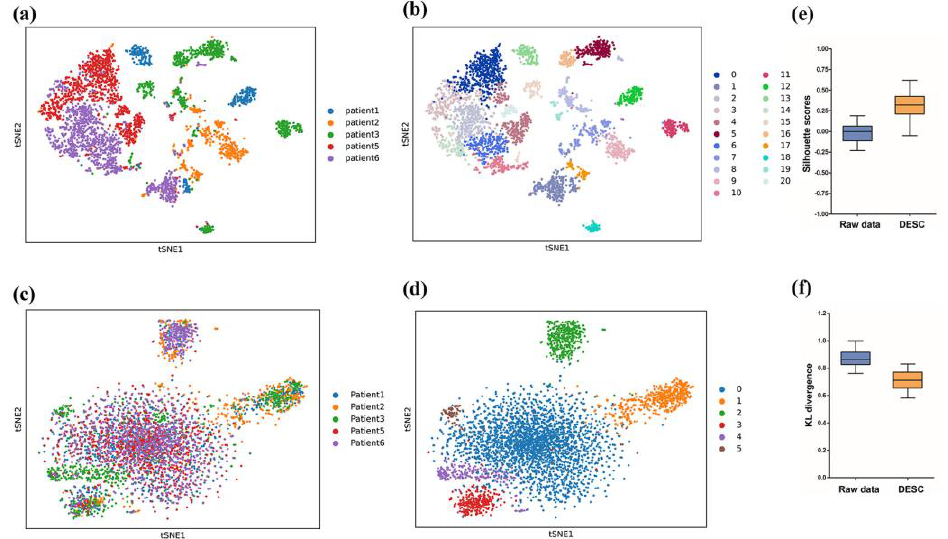
Figure 1. Batch correction and evaluation of multi-batch, integrated scRNA-seq data collected from ascites samples of patients with EOC. ( a , b ) T-SNE view of ascites samples before DESC correction, colored by batch ID ( a ) and cell clusters ( b ). ( c , d ) T-SNE view of ascites samples after DESC algorithm correction, colored by batch ID ( c ) and cell clusters ( d ). ( e , f ) Box plot of silhouette scores ( e ) and KL divergence ( f ) in raw data and data after DESC